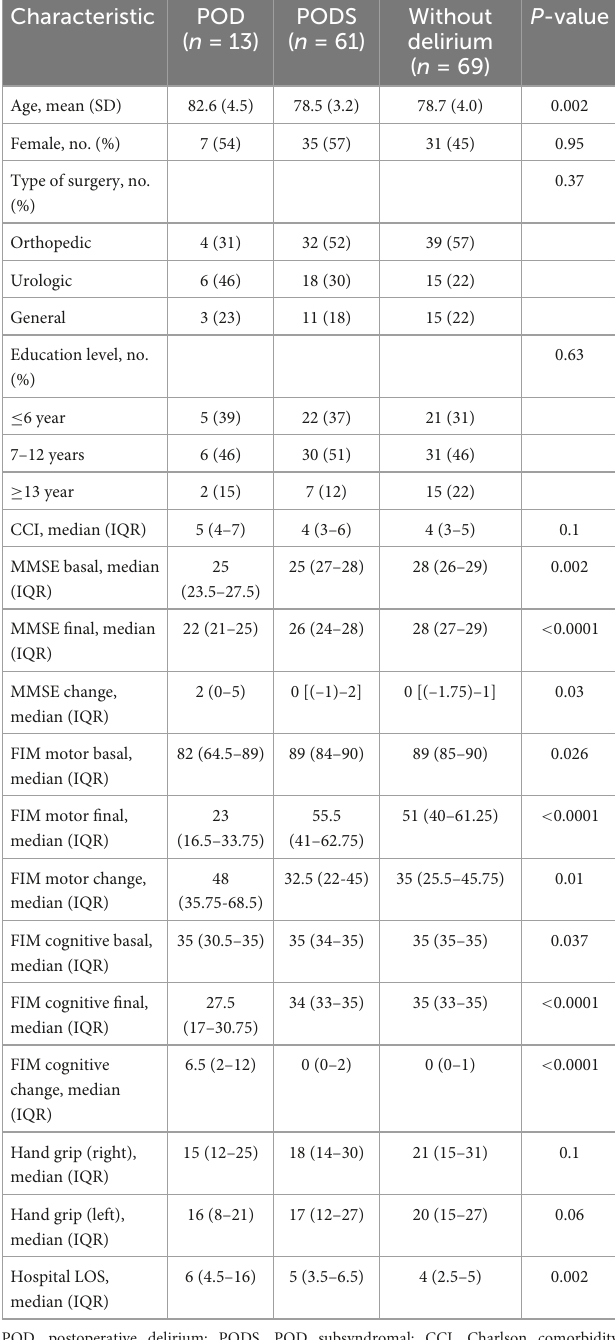
TABLE 3 Post hoc univariate analysis between POD, PODS and without delirium patients. Characteristic POD PODS ( n = 13) ( n =